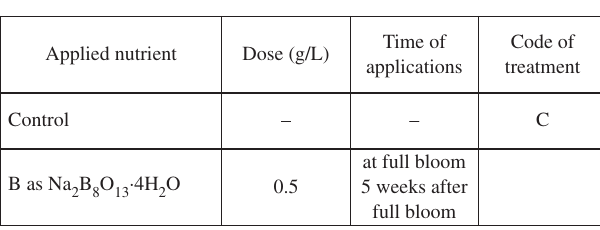
For spraying, Solubor (Disodium Octaborate Tetrahydrate – 20.9% B) was applied with 0.5% B solution